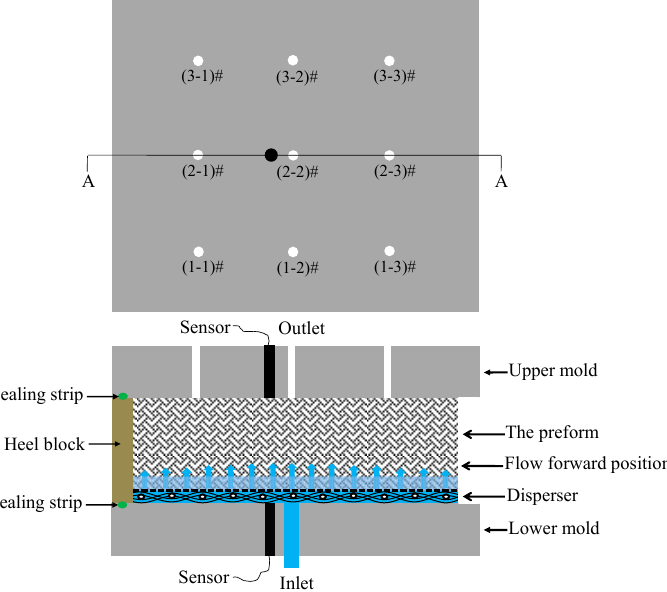
Figure 2. Diagram of pressure monitoring devices for z-RTM process.